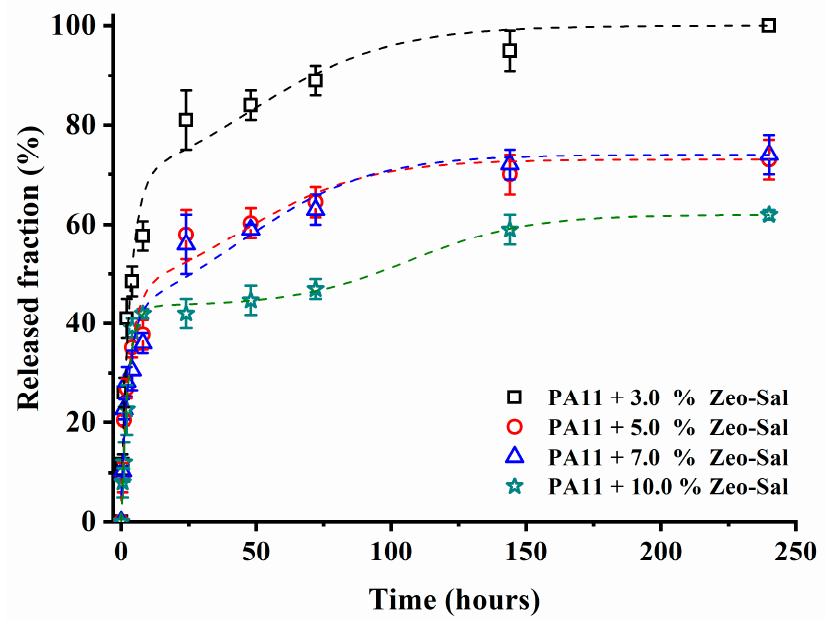
Figure 10. Released fraction of salicylate as function of time for films of PA11 filled with different Zeo-Sal loadings.